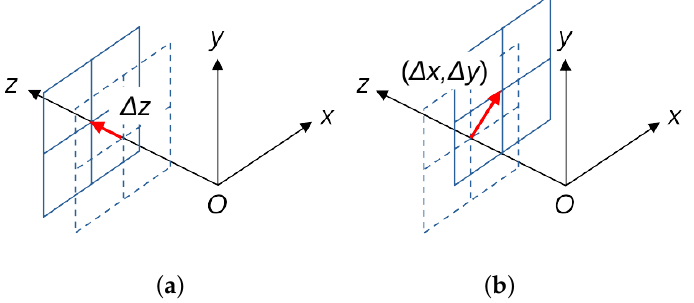
Figure 1. ( a ) Displacement in the direction of z -axis, and ( b ) 2D displacement in x - y plane.